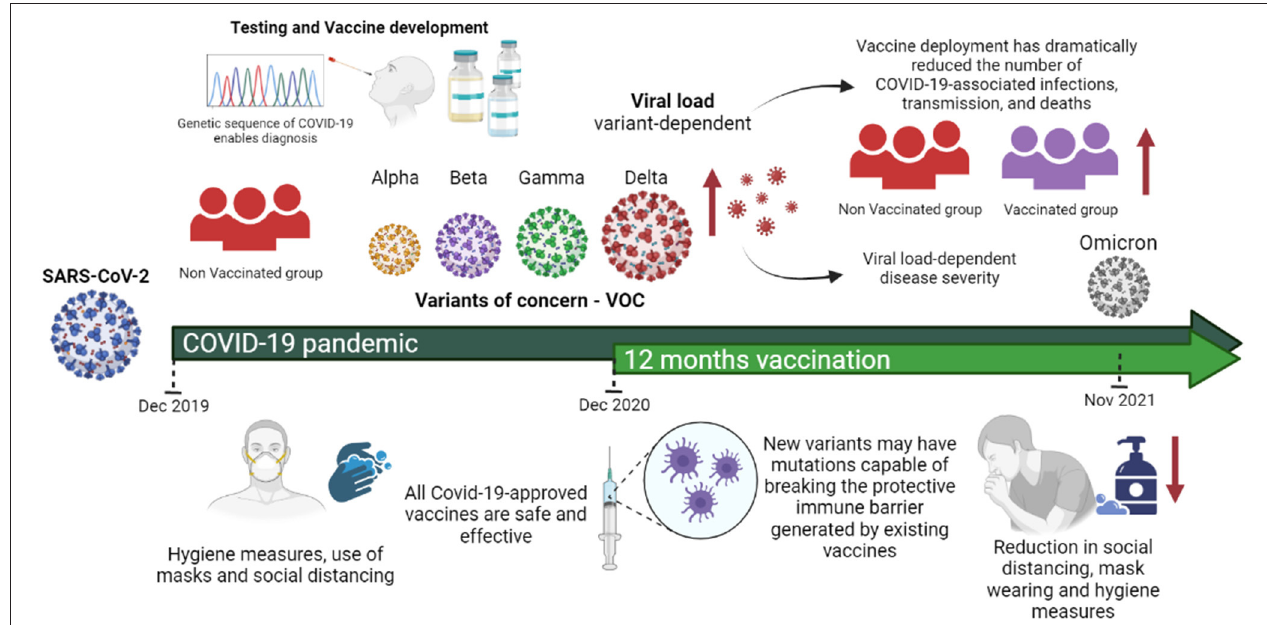
FIGURE 1 | SARS-CoV-2 variants of concern and their impact on viral load, disease severity and vaccine efficacy. All approved COVID-19 vaccines are effective against the variants in circulation. However, in general the effectiveness is slightly lower against them and new variants may have mutations capable of breaking the protective immune barrier generated by existing vaccines. Vaccines together with mitigating measures such as social distance, mask wearing, ventilation and hygiene are important to counter the spread of these variants. Evidence from clinical studies and animal models has indicated that SARS-CoV-2 infectious dose is one likely determinant of ultimate COVID-19 severity and prognosis. However, reduction in hygiene care, mask wearing and social isolation further greater viral transmissibility. In summary, most studies have concluded that vaccination reduces the risk of infection by VOC infection and accelerated viral clearance. Figure 1 was created with Biorender.com under academic